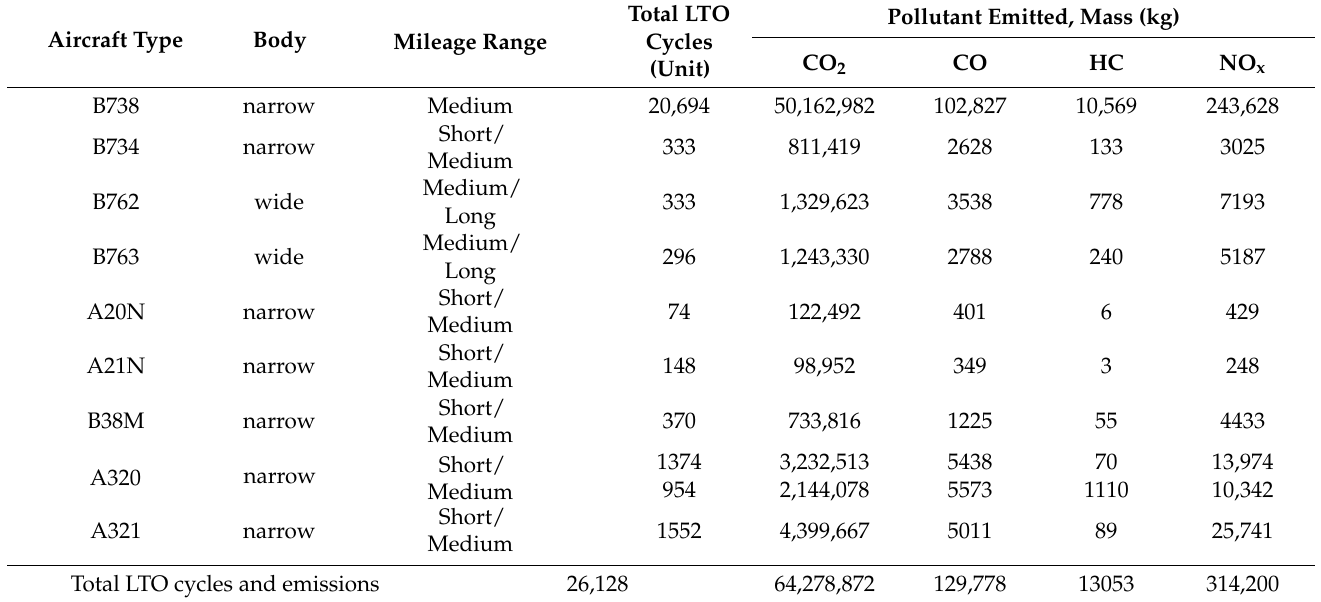
Table 5. Pollutants emitted per aircraft type and LTO cycles, 2019, determined by the EEA emission calculator.